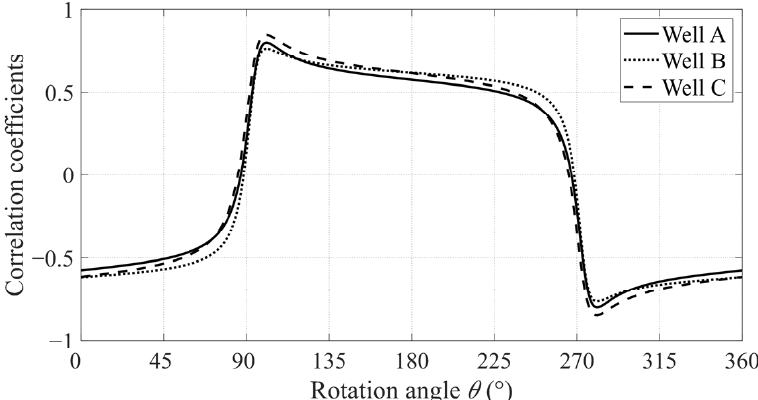
Figure 8. Correlation coefficients for varying rotation angle θ . The optimized rotation angle θ max is approximately equal to 101° for all understudied wells.